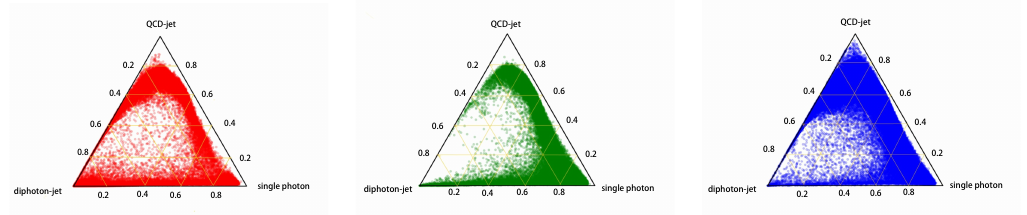
Figure 8 . A ternary plot for the diphoton-jet events, the single photon events and the QCD-jet events. The red, green and blue points represent the diphoton-jet events, the single photon events and the QCD-jet events, respectively.